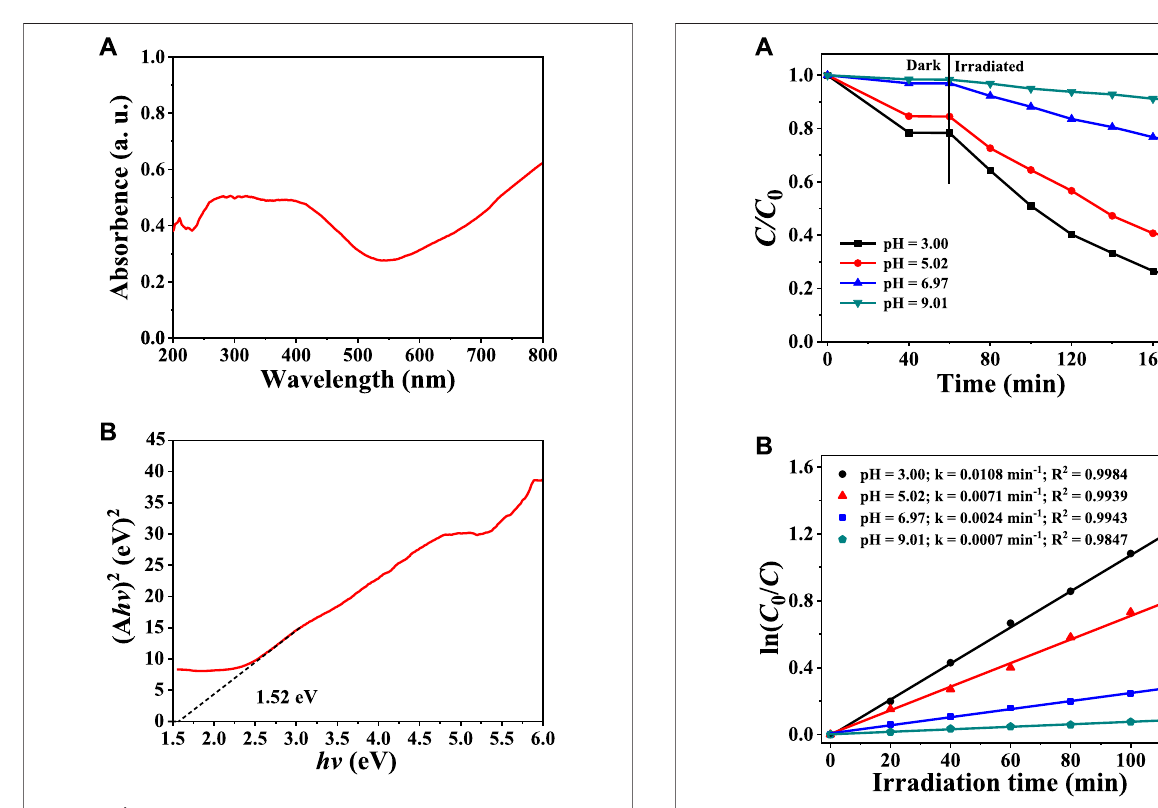
FIGURE 4 | (A) UV – Vis diffuse re fl ectance spectrum and (B) Tauc plot for obtaining the E g value of our prepared CuInS 2 sample. FIGURE 5 | (A) Adsorption and photocatalytic reduction of Cr(VI) over CuInS 2 in the mixed solution of Cr(VI) and CAP at different pH conditions (B) Corresponding kinetics plots for the photocatalytic Cr(VI) reduction reactions in (A) . ([Cr(VI)] = 10 mg/L, [CAP] = 10 mg/L, [catalyst] = 0.2